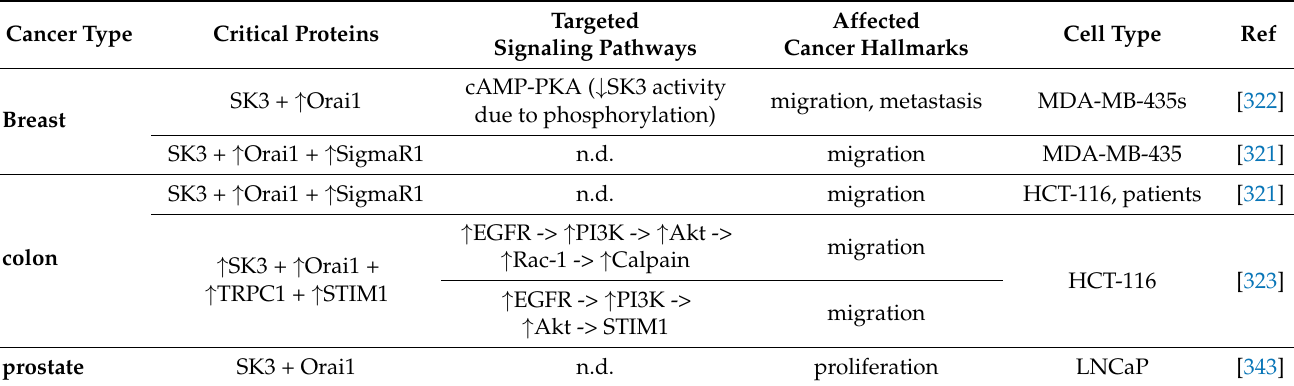
Table 3. Correlation of cancer types with detected SK3–Orai1 interplay and accessory proteins, targeted signaling pathways, types of affected cancer hallmarks, and corresponding cell